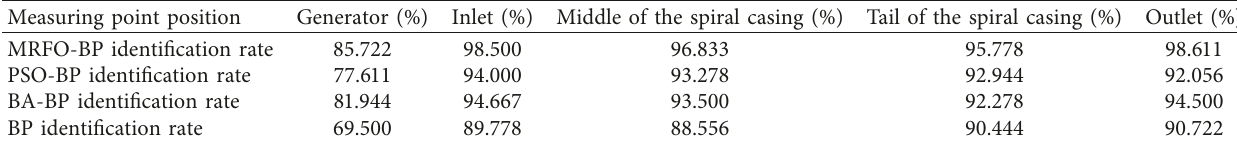
Table 9: Identification rates of three units based on four kinds of neural networks (comparative experiment). Measuring point